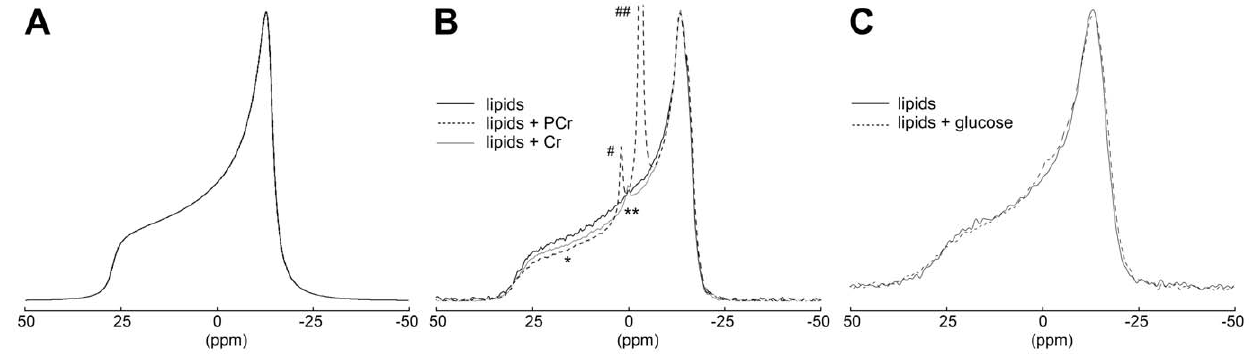
Figure 3. Interaction of phosphocreatine and creatine with lipid vesicles as visualized by solid-state 31 P-NMR spectroscopy. (A) Simulation of the static 31 P-NMR spectrum of a spherical liposome. (B), (C) Static spectra of lipid vesicles (CH/PE/PC/SP) incubated with (B) 25 mM Cr or PCr, or (C) 25 mM glucose were compared to spectra of control MLVs without additions. Spectra were recorded at 300 MHz and 303 K, referenced to 85% H 3 PO 4 and normalized. Differences between control and treated lipid vesicles observed in (B) but not in (C) are indicated: (*) change in the lineshape in the powder spectrum of Cr and PCr; (**) small resonance peak at , 0 ppm in the Cr spectrum due to isotropic lipids (micelles or other small aggregates); ( # ) resonance peak at 1.9 ppm in the PCr spectrum corresponding to inorganic phosphate; ( ## ) resonance peak at 2 3.2 ppm in the PCr spectrum corresponding to the phosphate moiety of